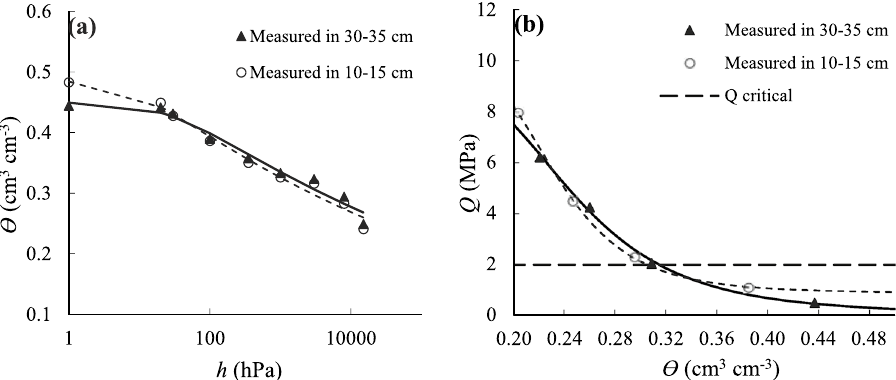
Figure 3. van Genuchten 35 function fitted to the SWRC ( a ) and modified van Genuchten 35 model fitted to the SPRC ( b ) data; well-known critical Q = 2.0 MPa is shown on the graph.